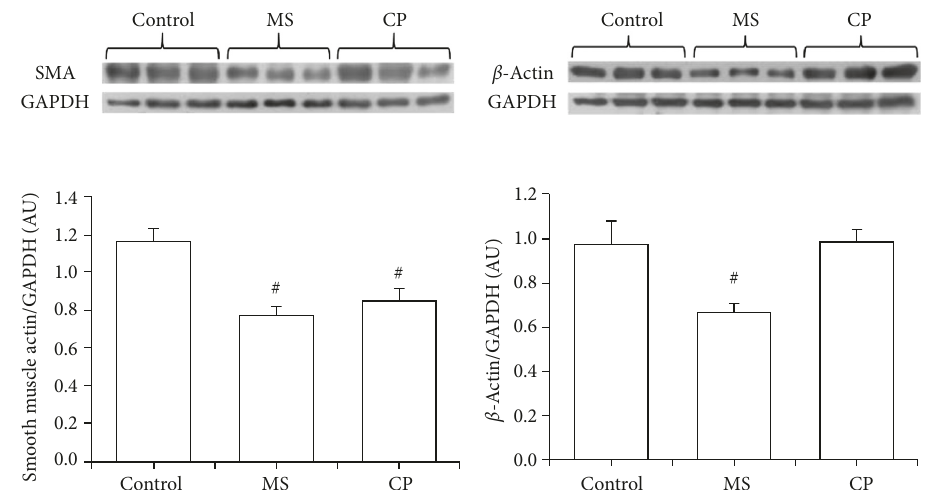
Figure 3: Expression of α - and β -actin in aortas from control, metabolic syndrome (MS), and critical period (CP) rats. MS rats ingested sucrose solution during six months; CP animals ingested sucrose solution during postnatal days 12 to 28. Control rats received tap water. A representative blot is shown above the graphics. SMA: smooth muscle actin; GAPDH: glyceraldehyde-3-phosphate dehydrogenase. There is a decrease in α -actin in both groups, and β -actin was only decreased in the MS group. Values are means ± SEM; # P ≤ 0 . 05; n � 8.